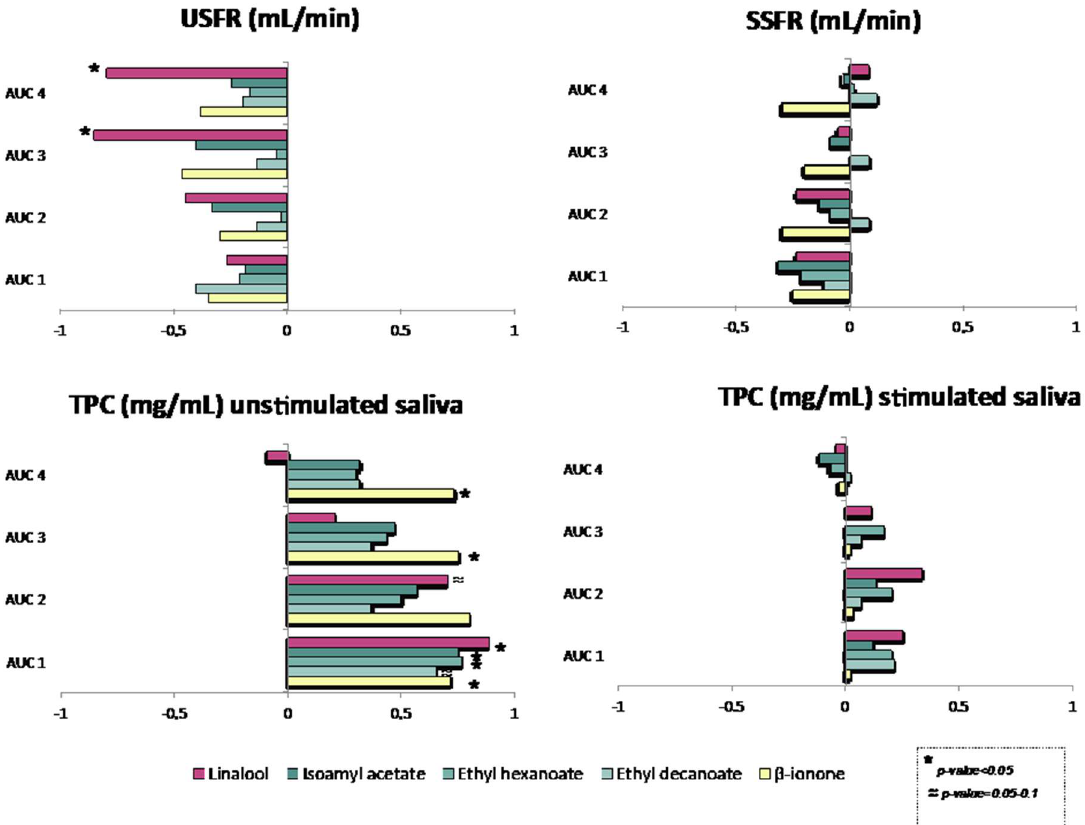
Figure 4. Spearman correlation matrix between salivary parameters and AUC data determined by PTR-ToF-MS.